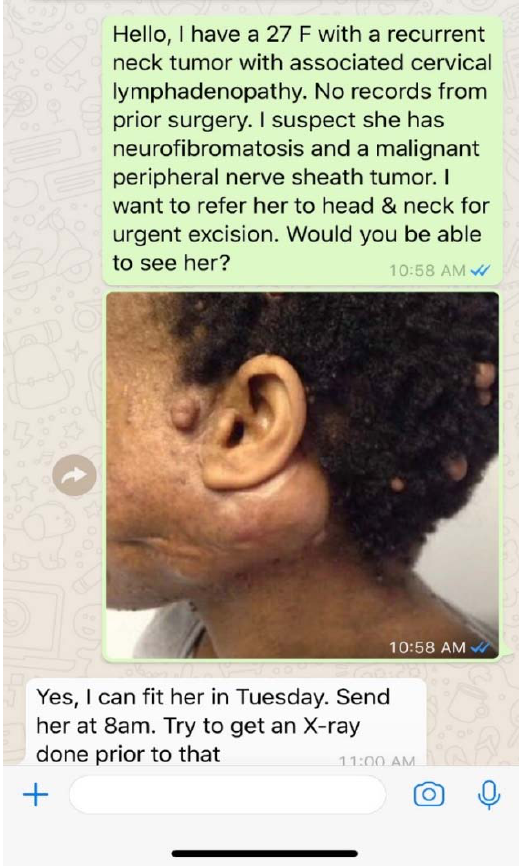
Figure 2. An example of secure direct messaging being used as a platform for teledermatology. Whatsapp is being utilized to tele-triage and coordinate care for a dermatology patient to sub-specialty care in Botswana.